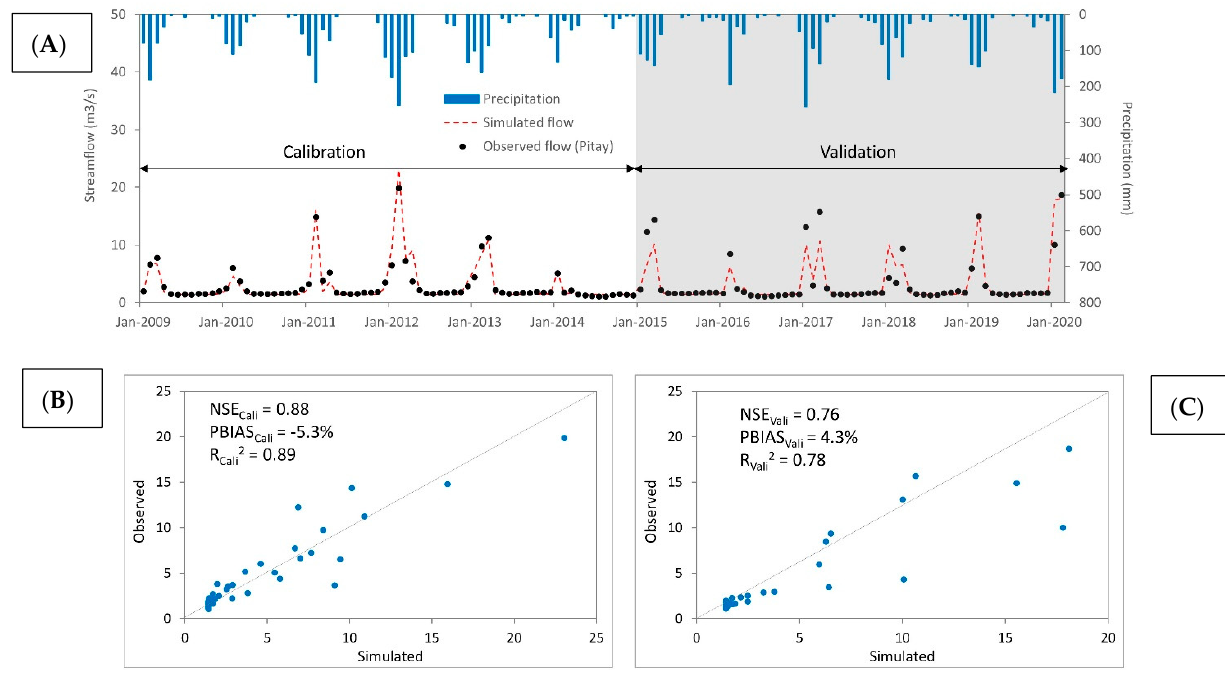
Figure 5. Monthly observed and simulated streamflow comparison during calibration and validation periods ( A ), with corresponding coefficient of determination ( B , C ).